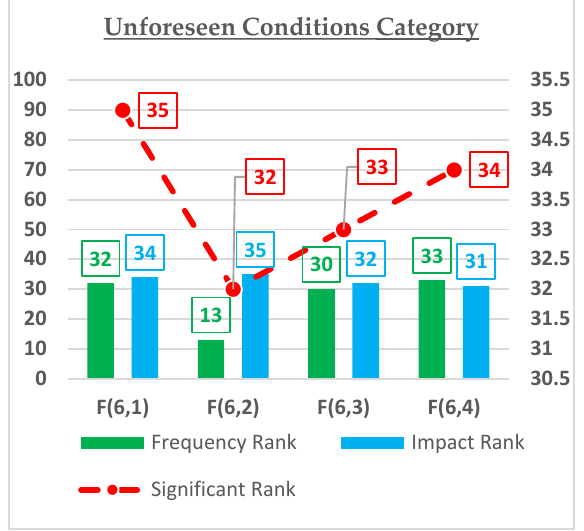
Figure 12. Significant risks in the unforeseen conditions category.